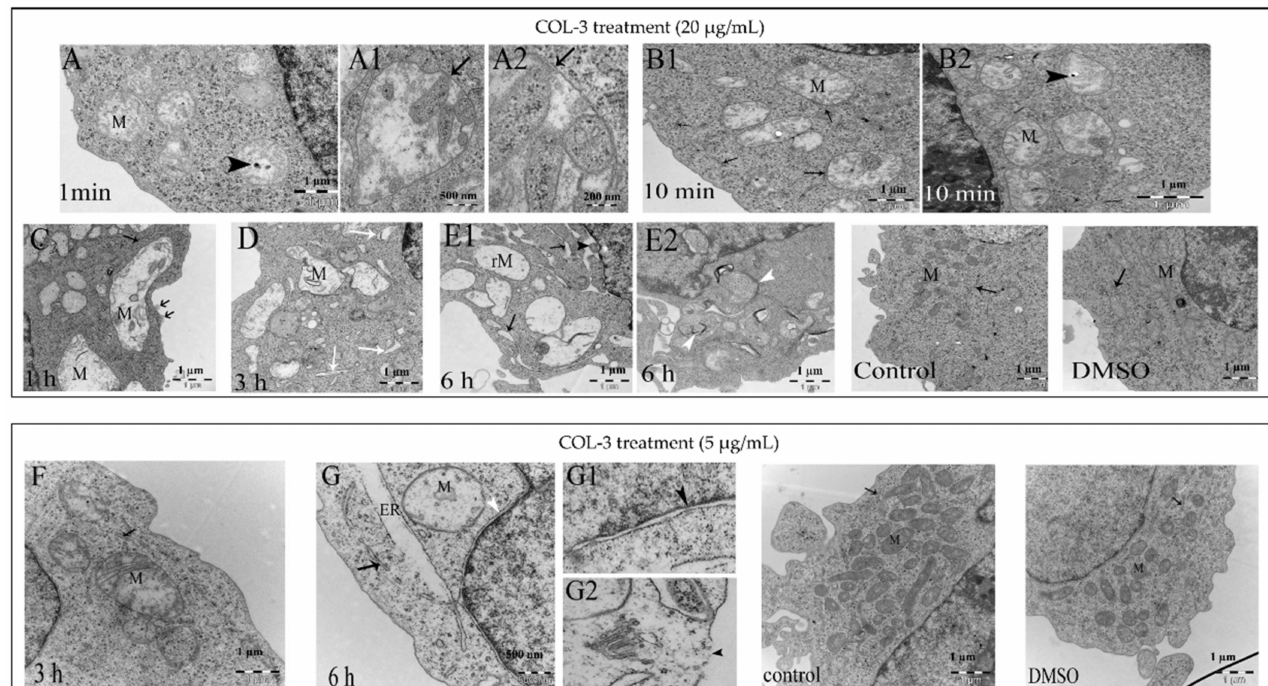
Figure 4. COL-3-induced ultrastructural changes (high magnification). K562 cells were treated with COL-3 (20 µ g/mL) for 6 h ( A – E ) or (5 µ g/mL) for 72 h ( F , G ). K562 control cells were untreated and/or treated with DMSO. Ultrastructural morphology was assessed with TEM. The following changes were visible in COL-3-treated (20 µ g/mL) cells: ( A ): After 1 min, swollen mitochondria (M) with disintegrated cristae and electron dense structure (black arrowhead). ( A1 , A2 ): higher magnification (500 nm) revealed intact mitochondrial membranes (black arrows). ( B1 , B2 ): After 10 min, the ER are approximated to mitochondria and devoid of ribosomes (closed head arrow). ( C ): After 1 h, early disruption of the plasma membrane (open head arrows). ( D ): After 3 h, ER dilatation with no ribosomes (white arrows). ( E1 , E2 ): After 6 h, ER and perinuclear cisternae dilatation (arrows and black arrowhead); ruptured mitochondria (rM) are enclosed in autophagosomes (white arrowhead). Control cells (DMSO-treated and untreated) show elongated mitochondria (M) with normal cristae and short segments of rough endoplasmic reticulum (closed head arrow). The following changes were visible in COL-3-treated (5 µ g/mL) cells ( F ): After 3 h, swollen mitochondria with displaced cristae (M) and mildly dilated ER (closed head arrow). ( G ): After 6 h, extensive mitochondrial swelling (M) with ruptured outer membranes, ER dilatation with disintegrated membranes connected to the dilated perinuclear cisternae and no ribosomes (white arrowhead). ( G1 , G2 ): Higher magnification (500 nm): Damaged nuclear and plasma membranes and disintegrated nuclear pore complex (black arrowheads). Controls: DMSO-treated and untreated cells after 72